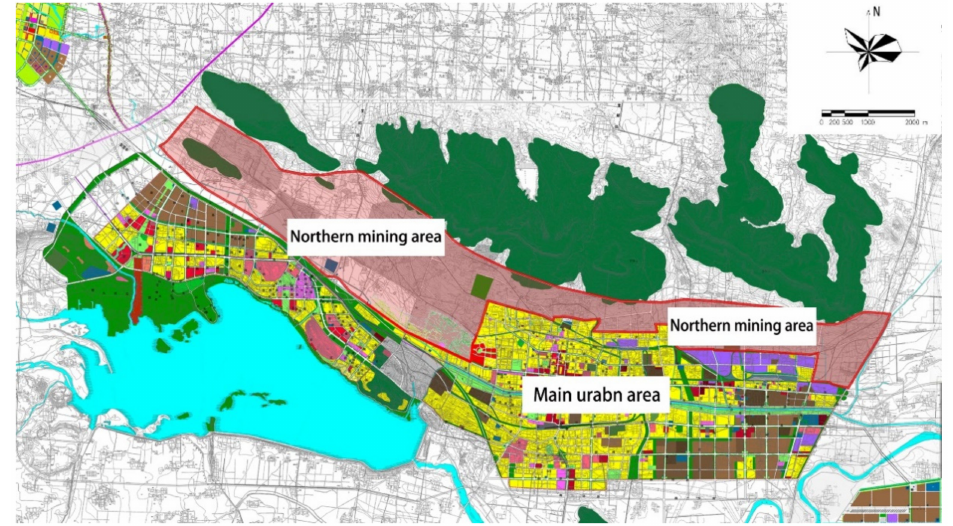
Figure 2. Location planning map of the Northern mining area of